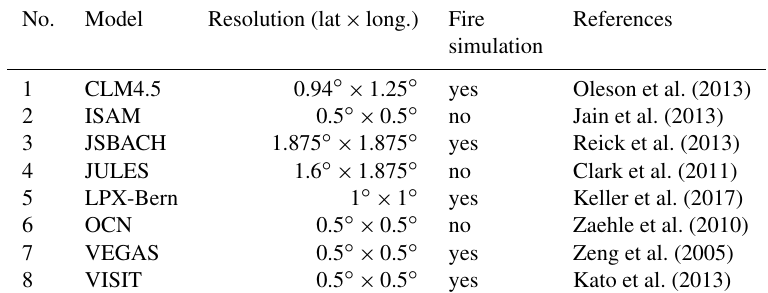
Table 1. TRENDY models used in this study.